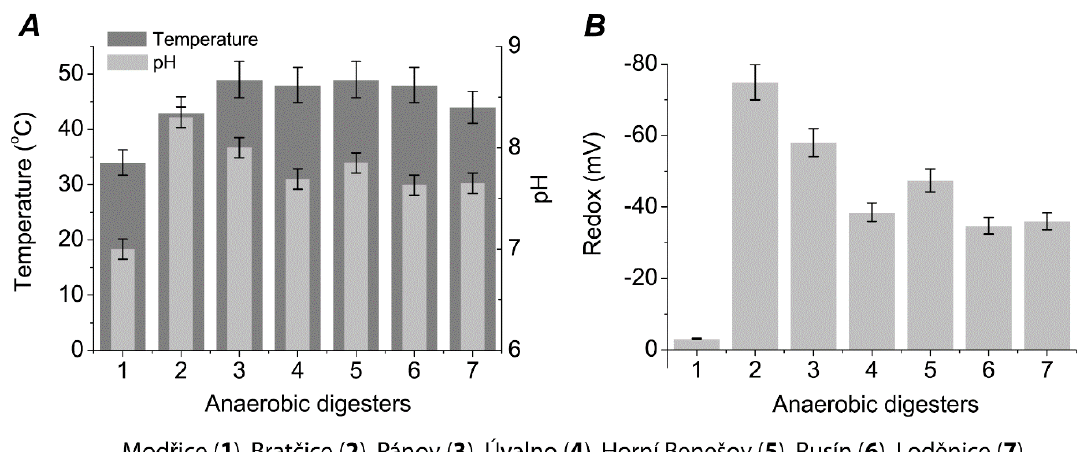
Figure 1. Physical characteristics of anaerobic digesters considered in this study (M ± SE, n = 3): temperature and pH ( A ), redox ( B ).